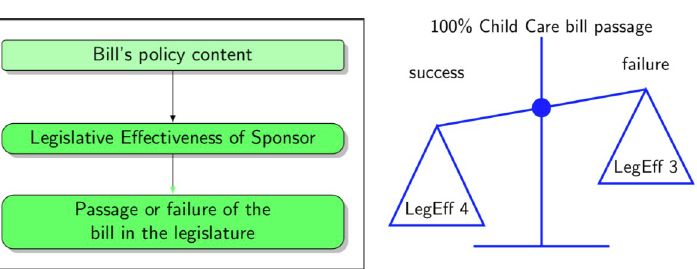
Fig 7. Legislative effectiveness moderated the relationship between the bill’s content and its legislative outcome. Scales indicate that for a hypothetical bill with its entire content focused on ChildCare, for example, a highly effective sponsor who successfully passed 4 bills would tip the balance in favor of passage (right).